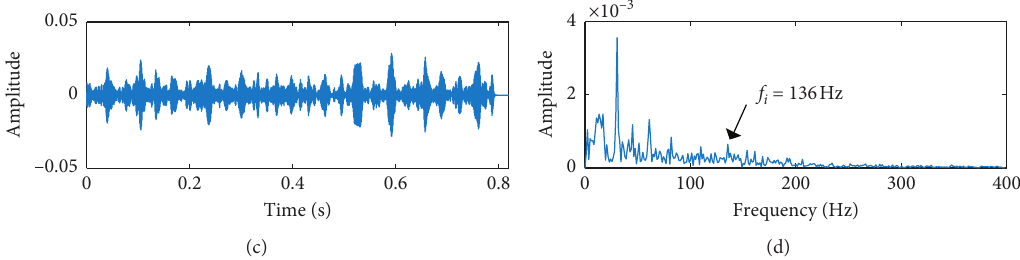
Figure 34: Multicomponents data in Figure 28(a) processed by different methods: (a) optimal mode extracted by the fixed-parameter VMD and (b) its envelope spectrum; (c) optimal mode extracted by PSO-based VMD and (d) its envelope